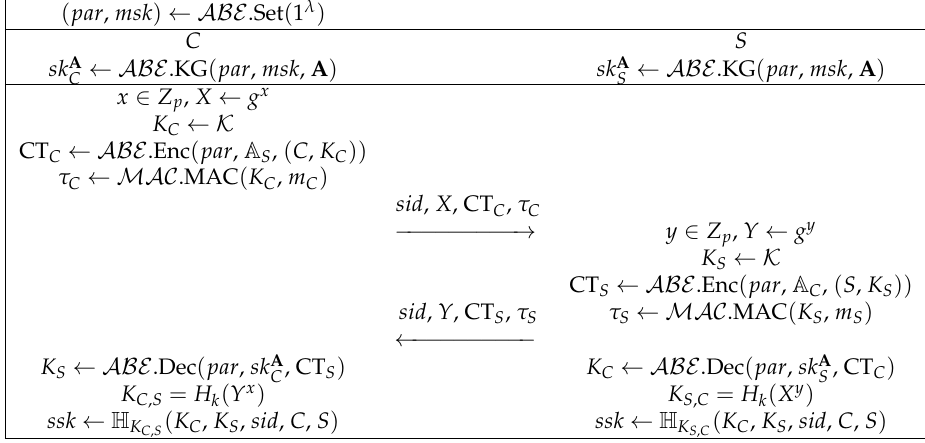
Figure 6. The one-round private and mutual authentication protocol OR-ABEDH, where m C = ( 0, sid , X , C ) , m S = ( 1, sid , Y , S ) , and C , S are not necessary elements and can be omitted from the protocol. For simplicity, all the related verification and decryption algorithms in the protocol are